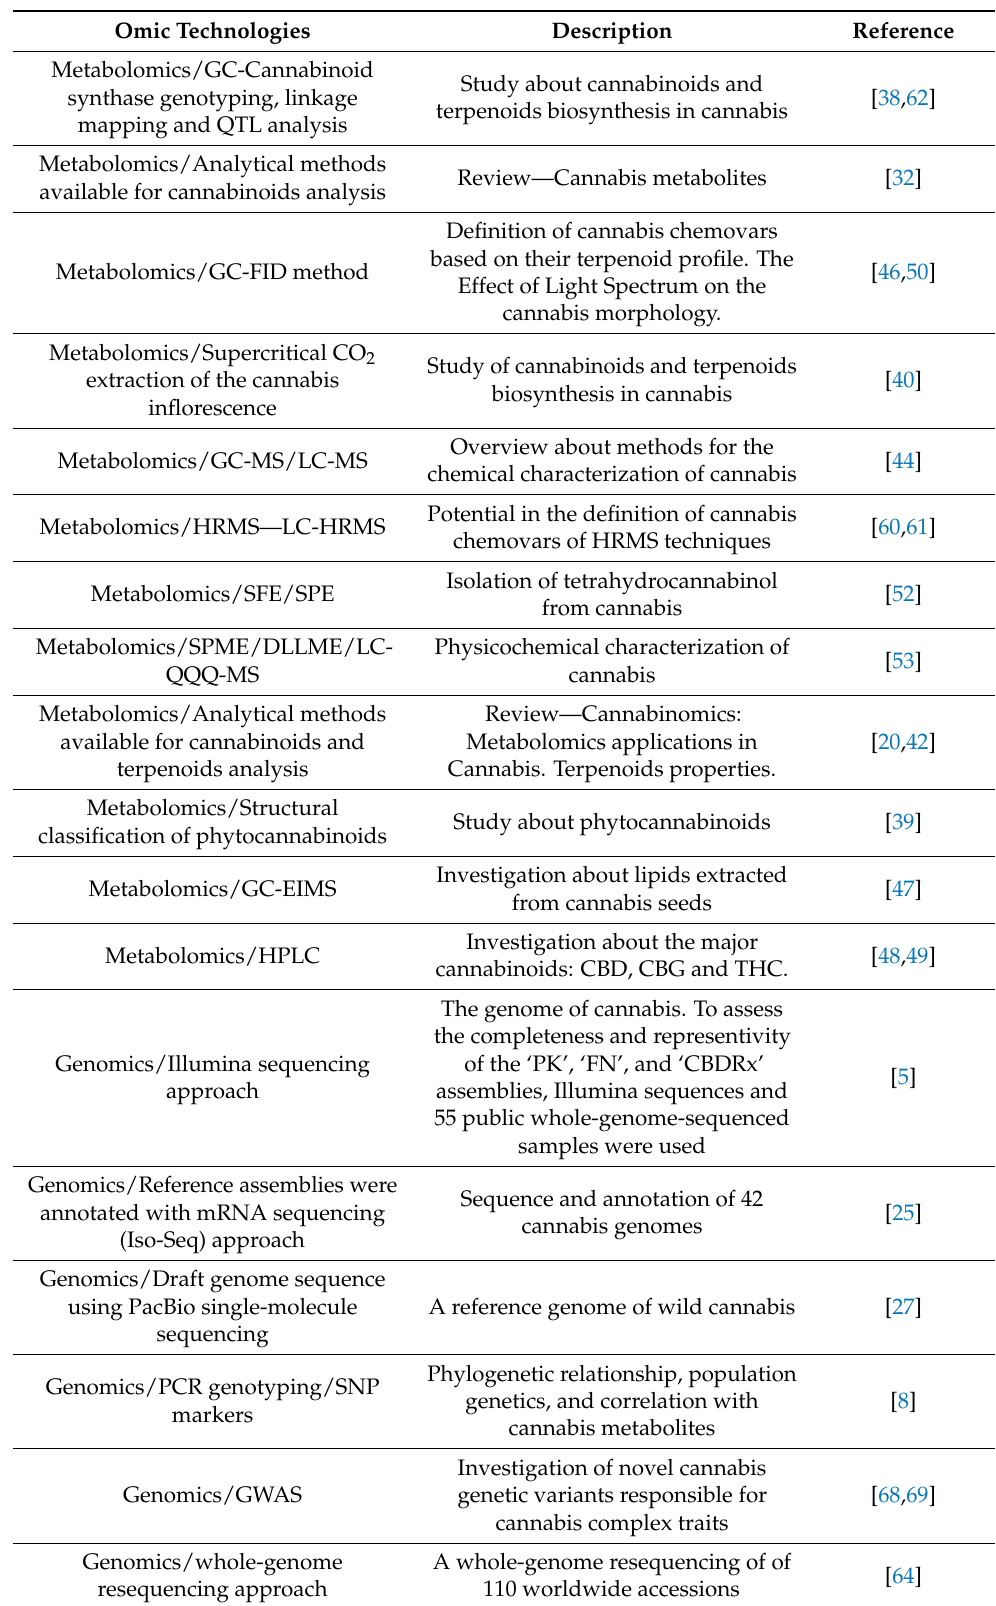
Table 2. Significant omics studies examined in this